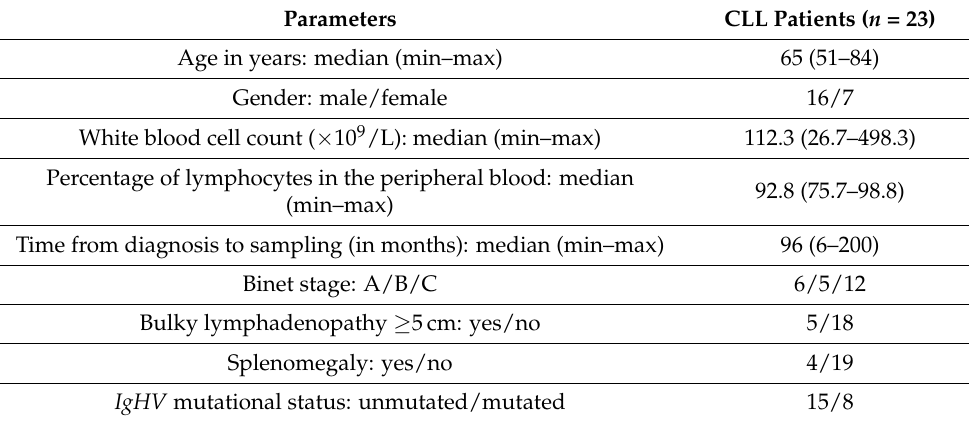
Table 1. Characteristics of the CLL